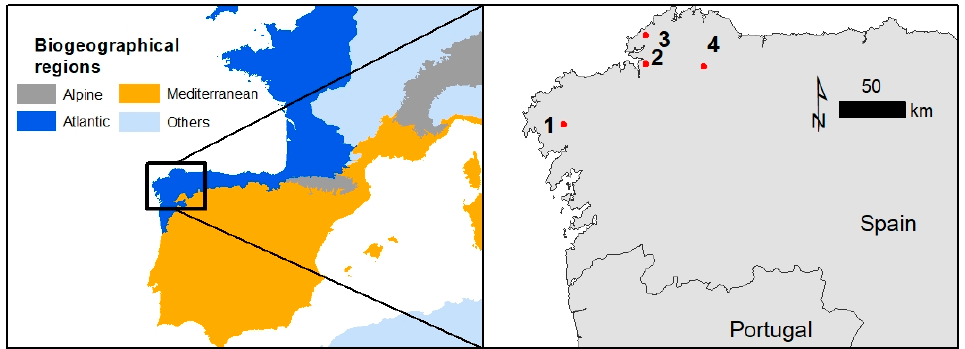
Figure 1. Location of the four 2 × 2 km study areas used in this analysis. Specific details about the coordinates of their upper-left corners (ETRS89/WGS84: Longitude, Latitude) are Area 1: − 8.9264°, 42.9738°; Area 2: − 8.1604°, 43.3858°; Area 3: − 8.1577°, 43.5838°; Area 4: − 7.6178°, 43.3625°.